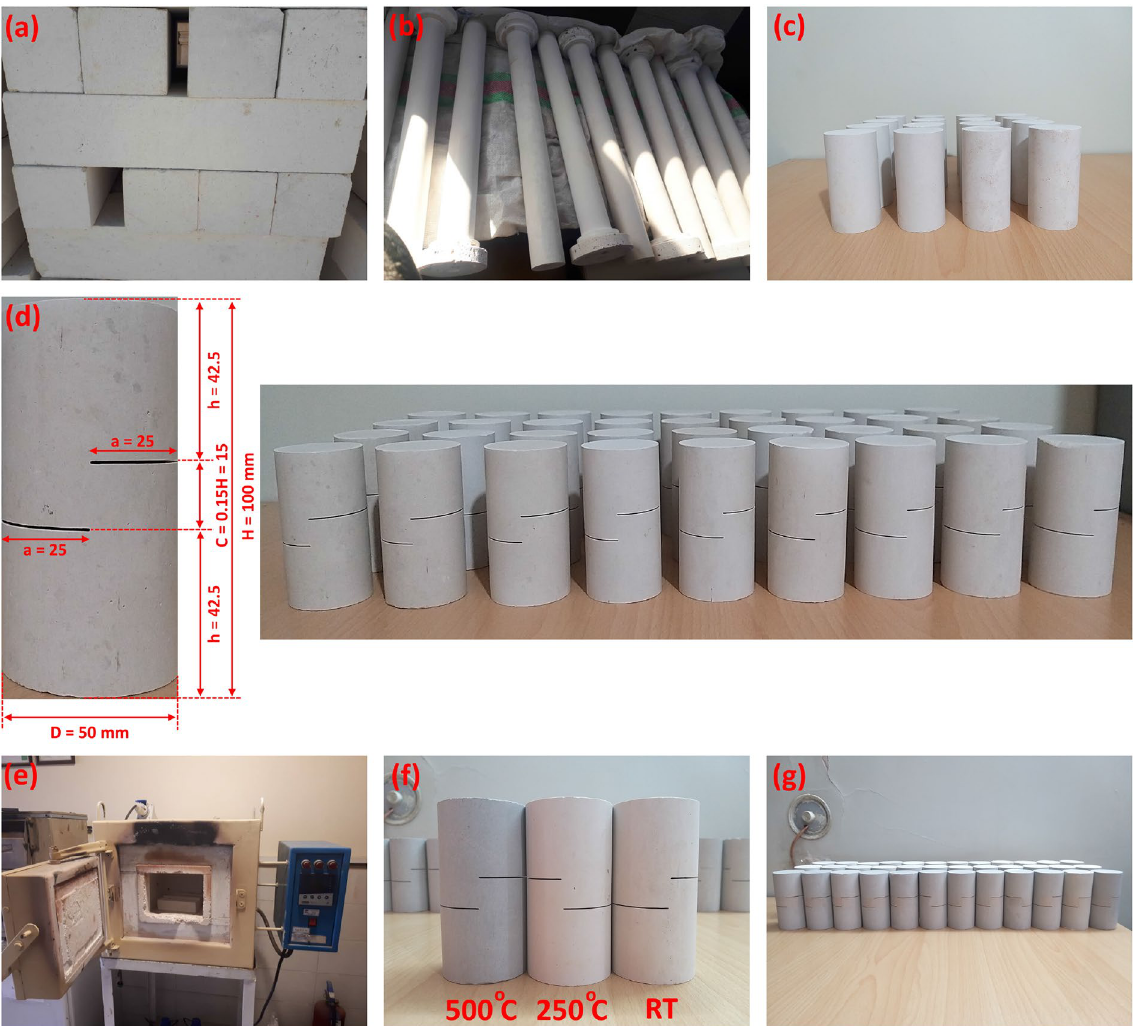
Figure 5. Stages of preparation of rock samples, ( a ) search for rock blocks, ( b , c ) cylindrical sample preparation, ( d ) SCC samples after making two artificial notches, ( e ) furnace used for thermal treatment, ( f , g ) SCC samples after thermal